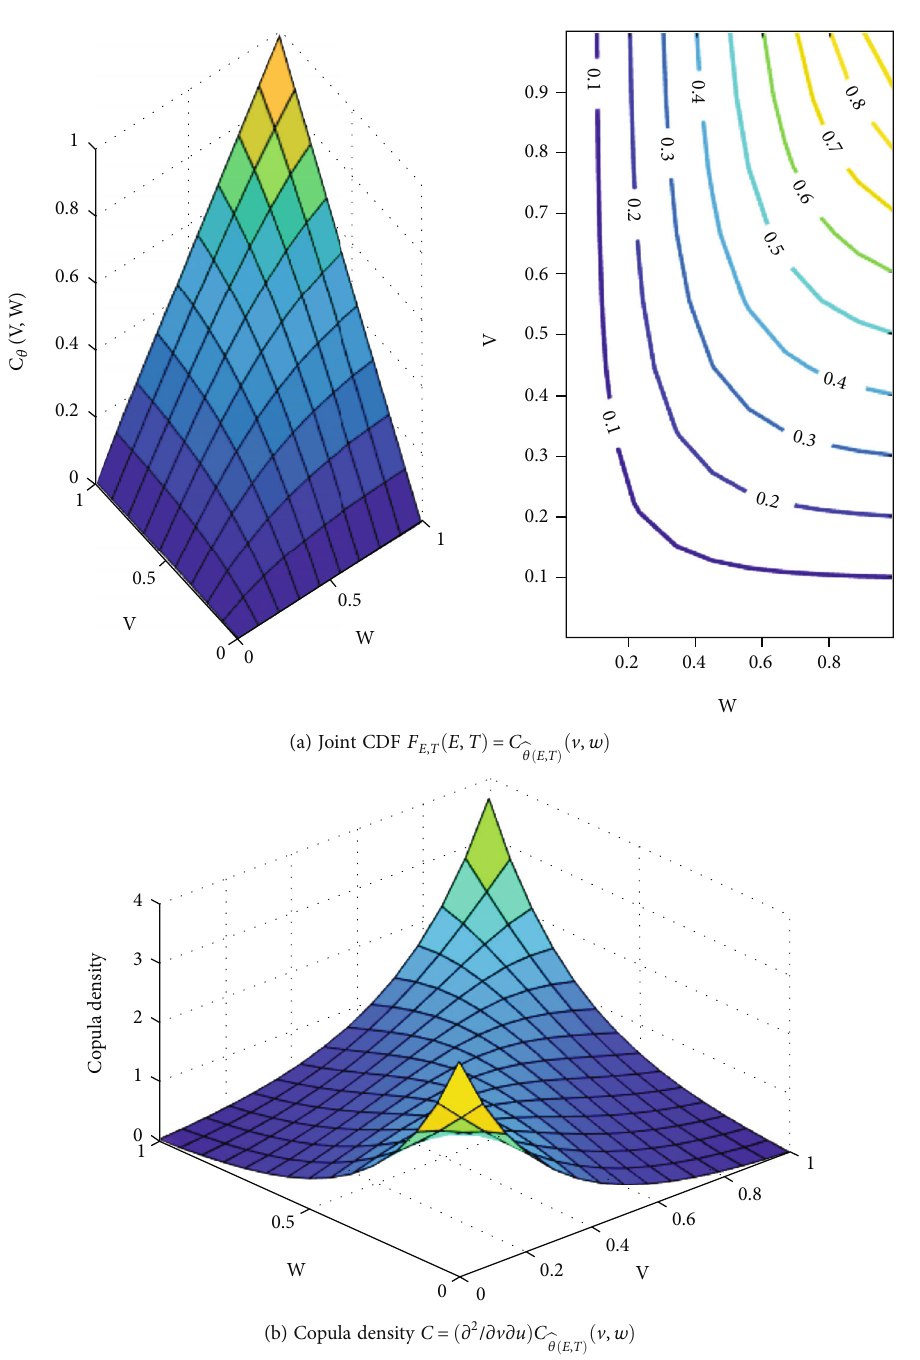
Figure 4: A 2-copula for T and E